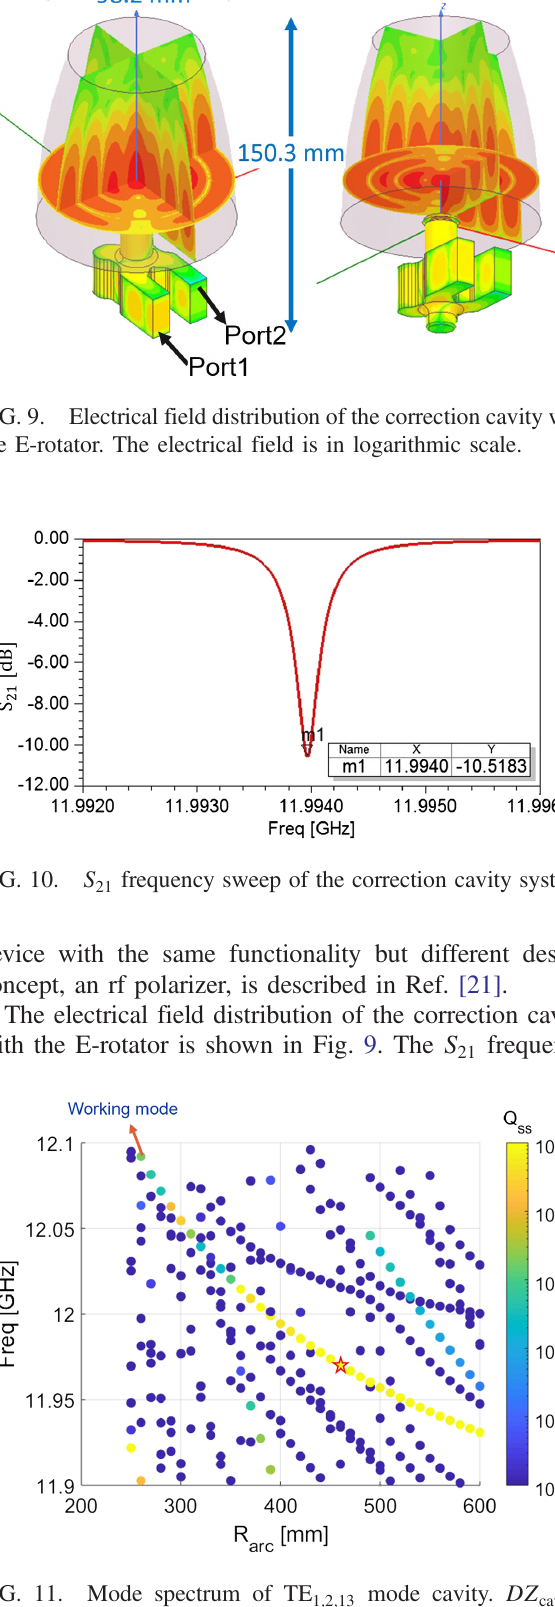
FIG. 11. Mode spectrum of TE 1 ; 2 ; 13 mode cavity. DZ 169.7 mm. R is 163.1 mm. Color bar represents the value cav of Q . ss